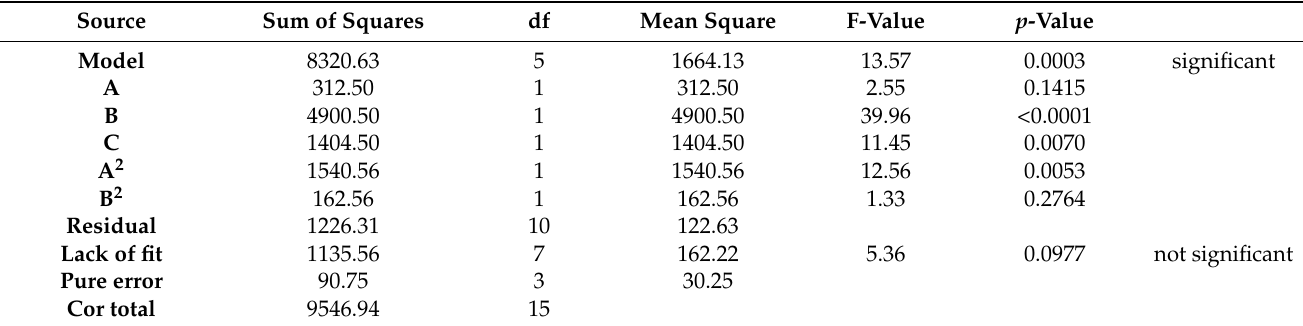
Table 6. ANOVA for the response surface reduced quadratic polynomial model for DCSLM with threshold concentration of